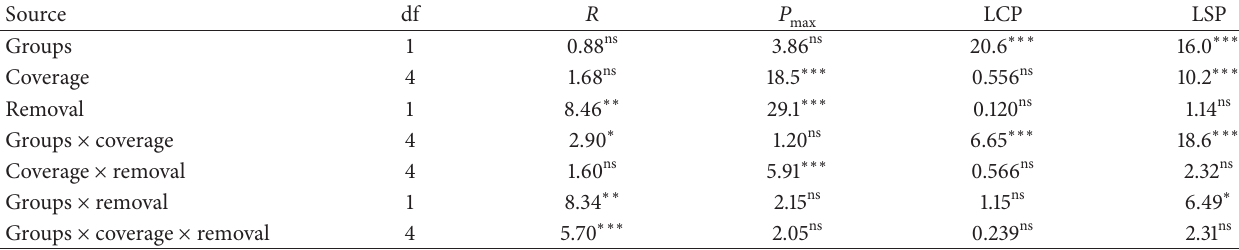
Table 2: Effects of epiphyllous coverage (0%, 25%, 50%, 75%, and 100%), epiphyllous groups (groups: liverworts and lichens), and treatment of removal (preremoval and postremoval) on photosynthetic parameters: respiration rate (𝑅) , maximum rates of photosynthesis (𝑃 max ) ,